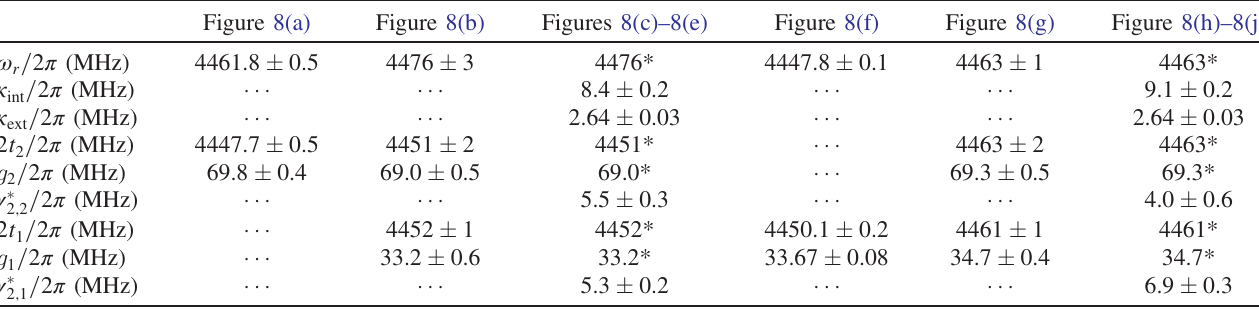
TABLE III. Extracted values from the data shown in Fig. 8 by fitting the line traces as described in the text. For the parameters indicated by Figs. 8(a) and 8(b), a Hamiltonian fit to the resonance positions is performed. For the parameter indicated with Figs. 8(c) – 8(e), a master-equation fit is performed by fixing the parameters obtained from the previous fit (indicated by *). For the parameters indicated by Figs. 8(f) and 8(g), a Hamiltonian fit to the resonance positions is performed. For the parameter indicated with Figs. 8(i) – 8(k), a master-equation fit is performed by fixing the parameters obtained from the previous fit (indicated by